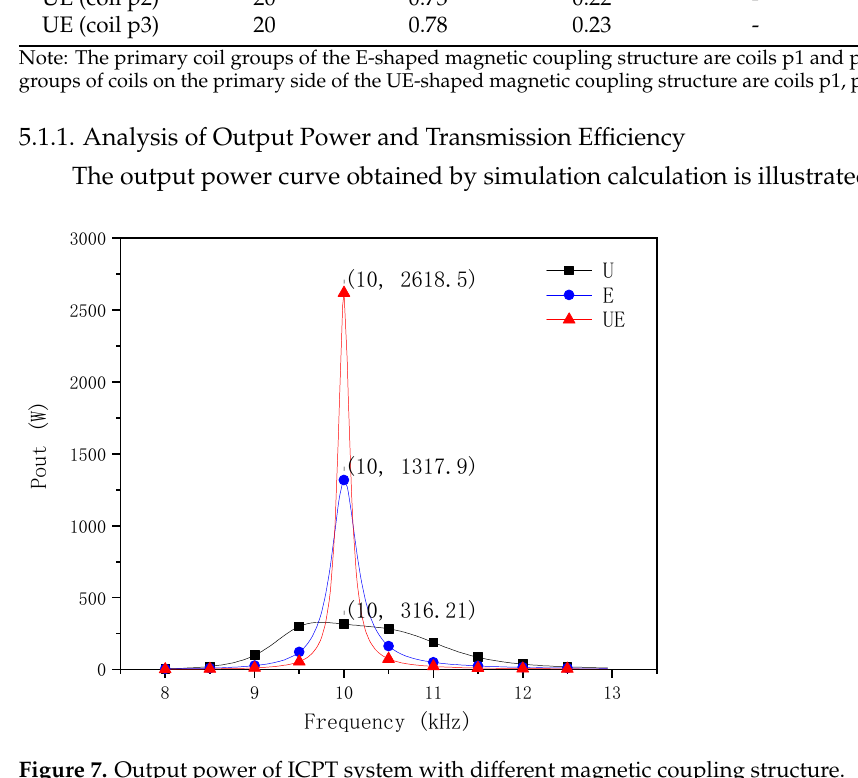
Figure 7. Output power of ICPT system with different magnetic coupling structure.